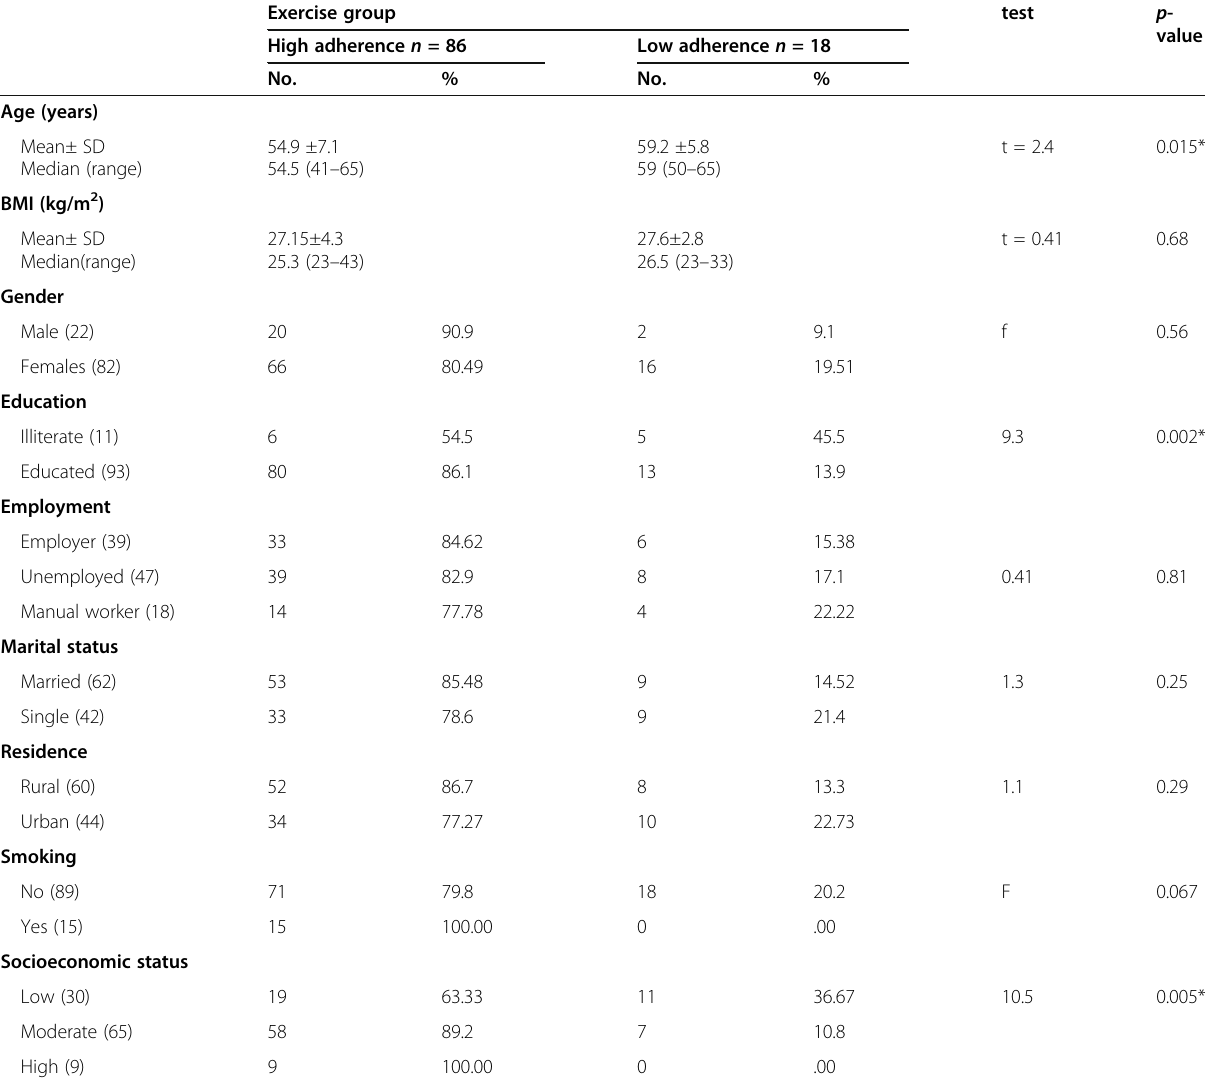
Table 3 Relation of adherence level to HEP among exercise group with regard to demographic characteristics Exercise group